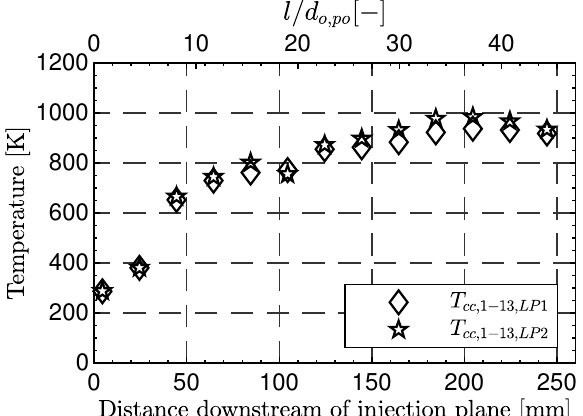
Figure 12. Temperature distribution of hot gas thermocouples downstream of injection plane.